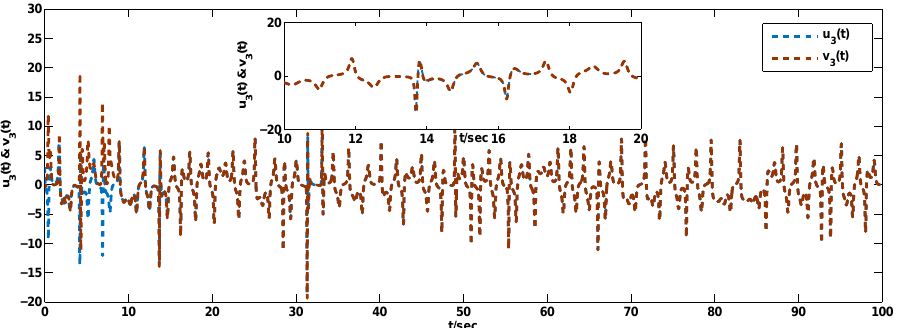
Figure 14. Synchronized time response of the states ( t , u 3 ( t )) and ( t , v 3 ( t )) of the drive-response systems (13) and (14) with fractional order q = 0.9.